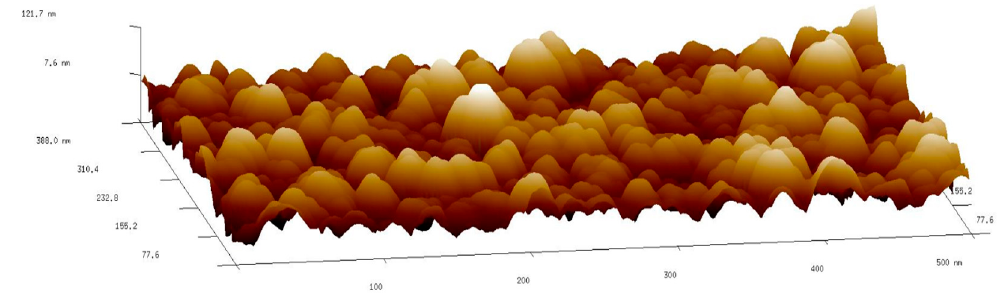
Figure 8. Surface topology by AFM.